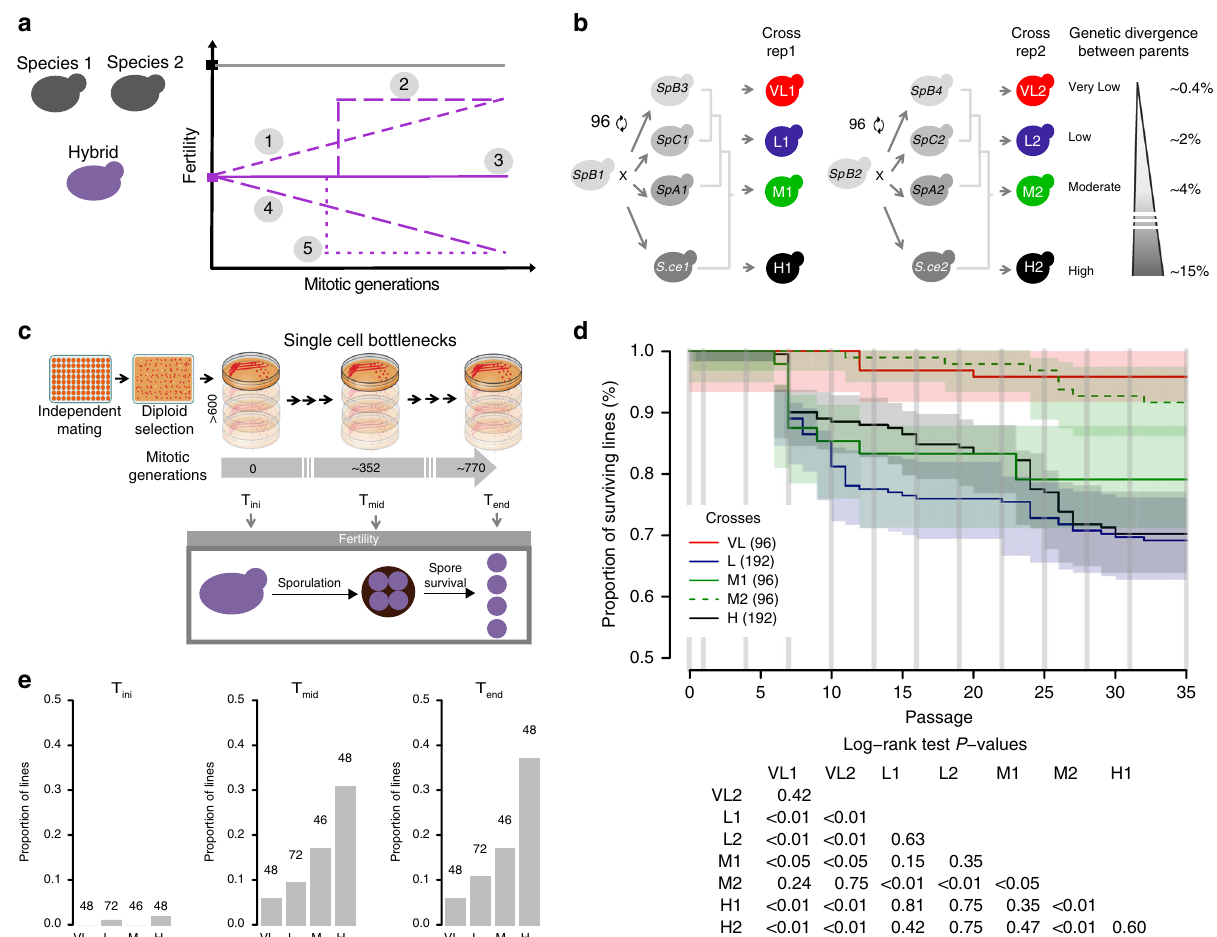
Fig. 1 Neutral evolution of yeast hybrids and its impact on viability and sporulation ability. a Evolution of fertility during mitotic proliferation of hybrids between species: Potential scenarios: (1) Gradual recovery over time, (2) rapid sudden recovery, (3) no signi fi cant recovery, (4) decline over time, (5) rapid and sudden decline. b Crosses were performed among S. paradoxus lineages (VL div , L div , and M div ) and with S. cerevisiae (H div ). Each type of cross involves two biological replicates, i.e., involving independent strains, and each individual cross was performed independently to represent independent hybridization events. c The 672 hybrids were evolved in conditions of weak selection to examine the neutral spontaneous changes of fertility. Mitotic propagation was performed through repeated bottlenecks of single cells. Fertility was measured by estimating spore viability after meiosis at T ini , T mid , and T end . d Survival rates vary among lines. Timing of each glycerol stock indicated by vertical grey lines. Logrank test pairwise comparisons FDR corrected P -values are shown. e Fraction of lines that lost their sporulation capacity at T ini , T mid , and T end . The number of strains tested per cross type is indicated over the corresponding